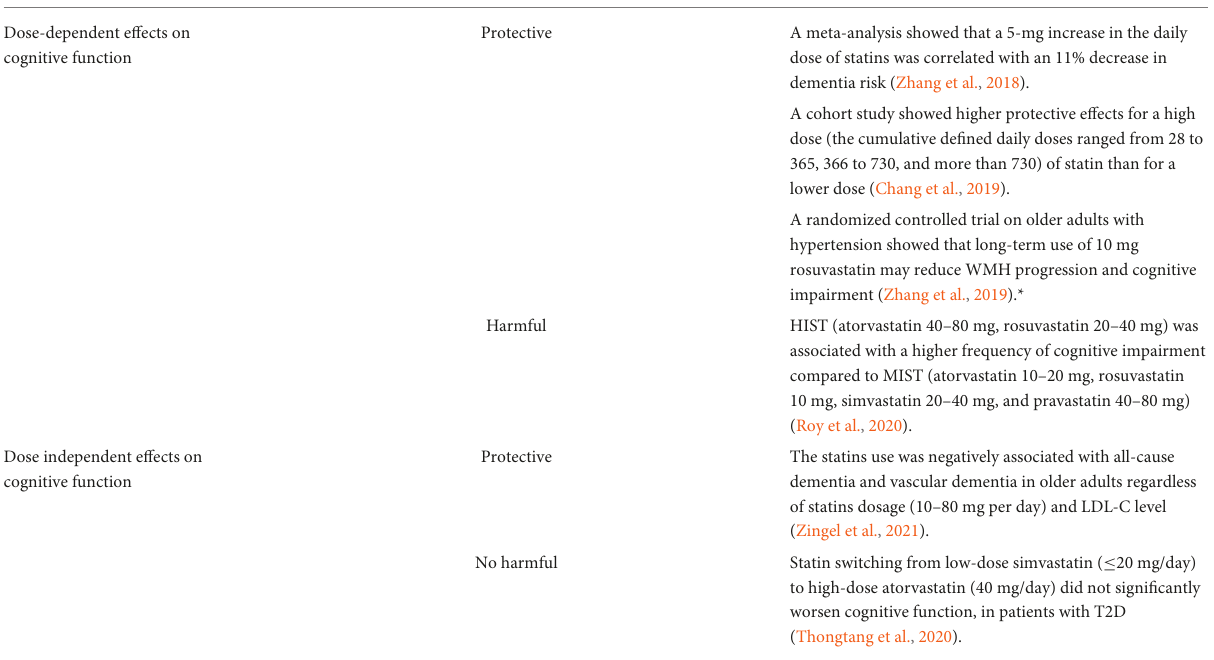
TABLE 3 The effect of statins dose intensification on cognitive function.